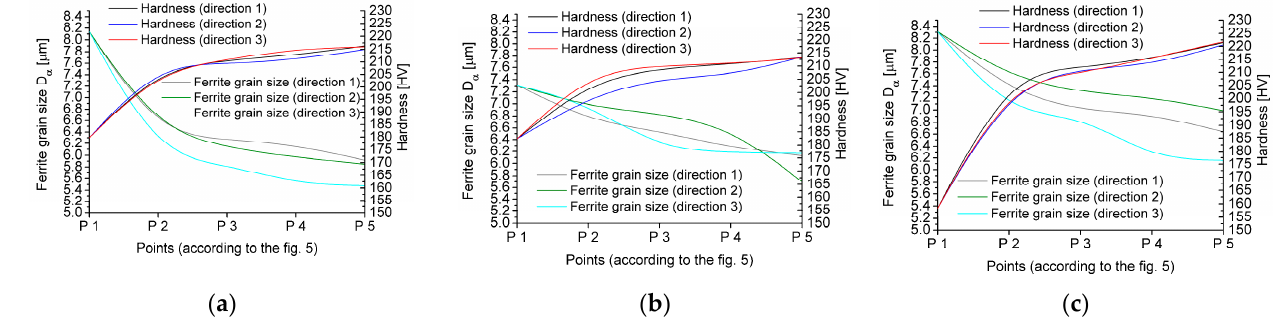
Figure 16. Distribution of the ferrite grain size and hardness of 20MnB4 steel after physical modelling of the rolling process of a wire rod with a diameter of 5.5 mm: ( a ) test variant V1, ( b ) test variant V2, and ( c ) test variant V3.